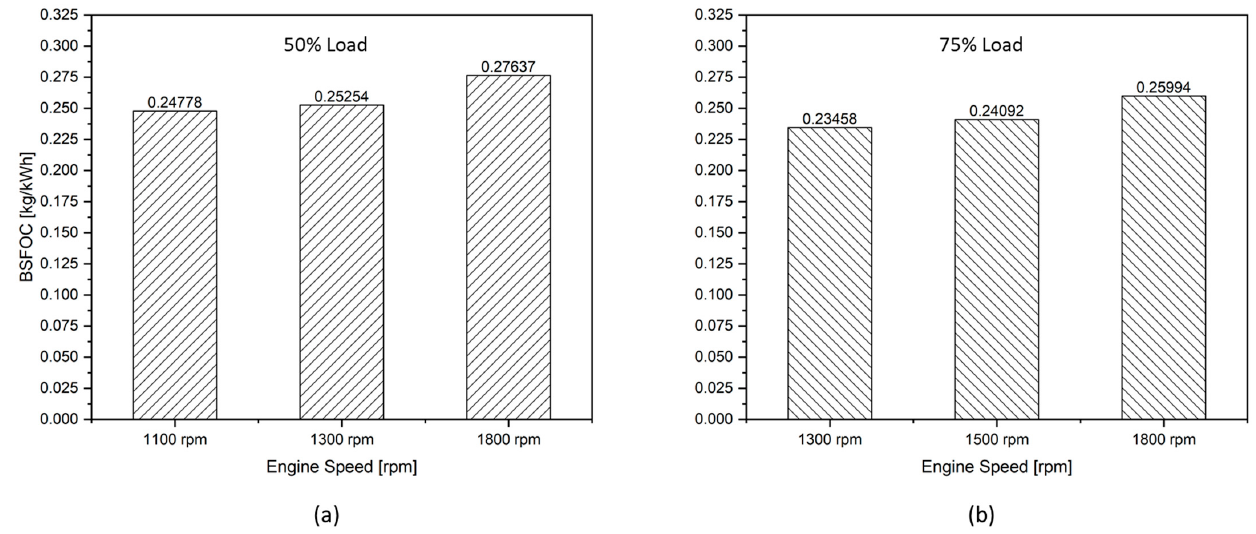
Figure 10. BSFOC of the engine at ( a ) 50% and ( b ) 75% load according to engine speeds.